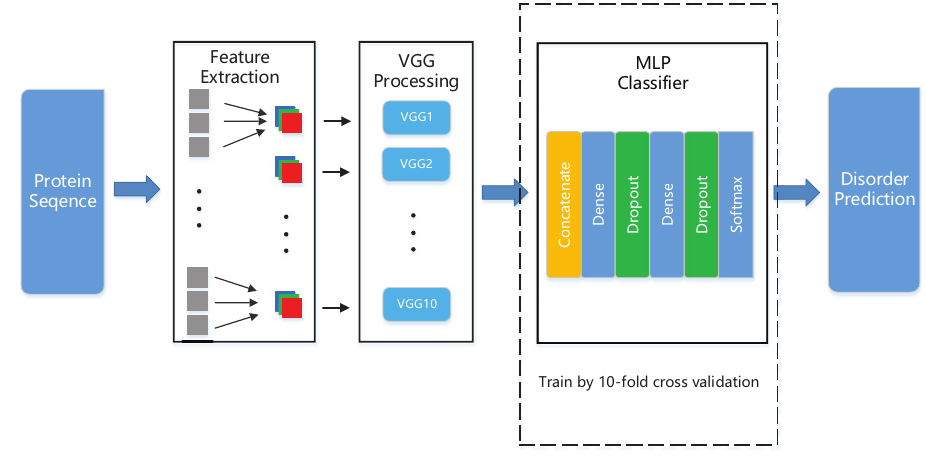
Figure 1. The overall framework of the